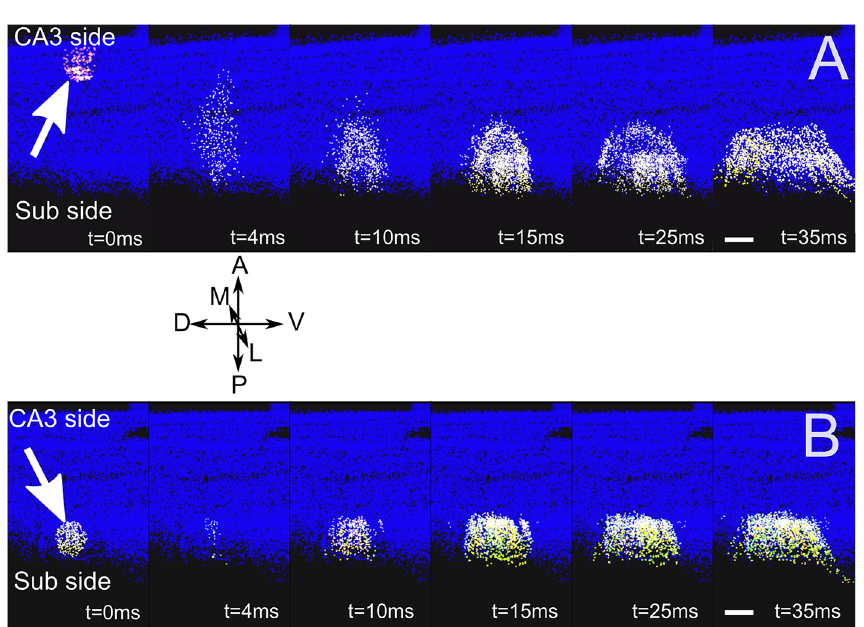
Figure 8. 500 µm slice simulation. ( A ). Snapshots from a movie (Suppl. Movie 1) illustrating a simulation of a 500 µm thick transversal slice stimulated from the CA3 side (white arrow). Each dot corresponds to a CA1 neuron/interneuron. The activation of a group of about 200 PCs (white spots on the left) by a single stimulus (t = 0 ms) induces a rapid transversal (Antero-posterior; A-P) invasion of the slice (t = 4,10 ms) which subsequently propagates longitudinally (medio-lateral; M-L). ( B ) Similarly to ( A ), stimulation of the slice from the subiculum side (white arrow). preferentially activates PCs whose activity remains confined to the subiculum side with little longitudinal propagation. Images have been generated through the software Vsimpl 60 . Scale bar 100 µm. A neuron’s activity is color coded from blue (rest) to white (spike), to visualize action potentials, with a fixed 2 ms transition